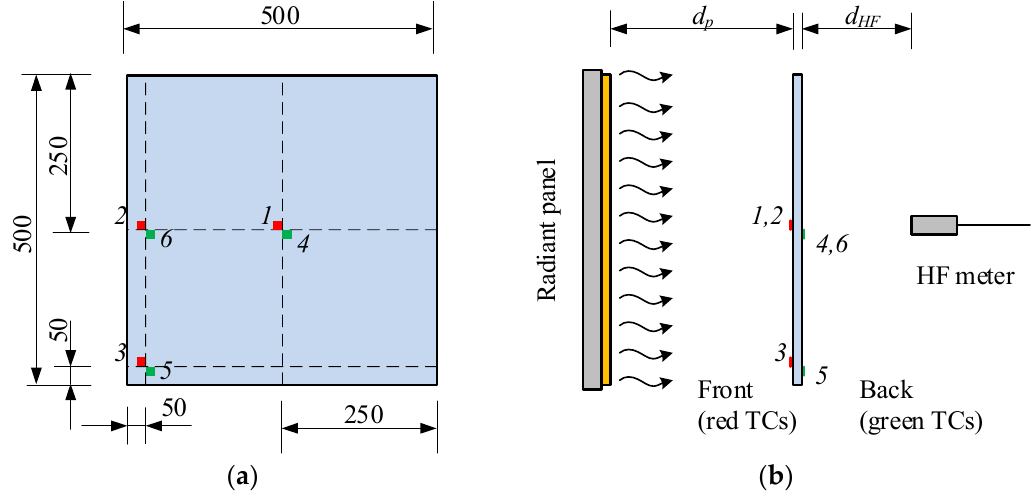
Figure 4. Schematic representation of the measurements: ( a ) glass panel with TCs seen from the back; ( b ) test setup with radiant panel and HF meter (dimensions in mm). Table 2. Overview of the tests.